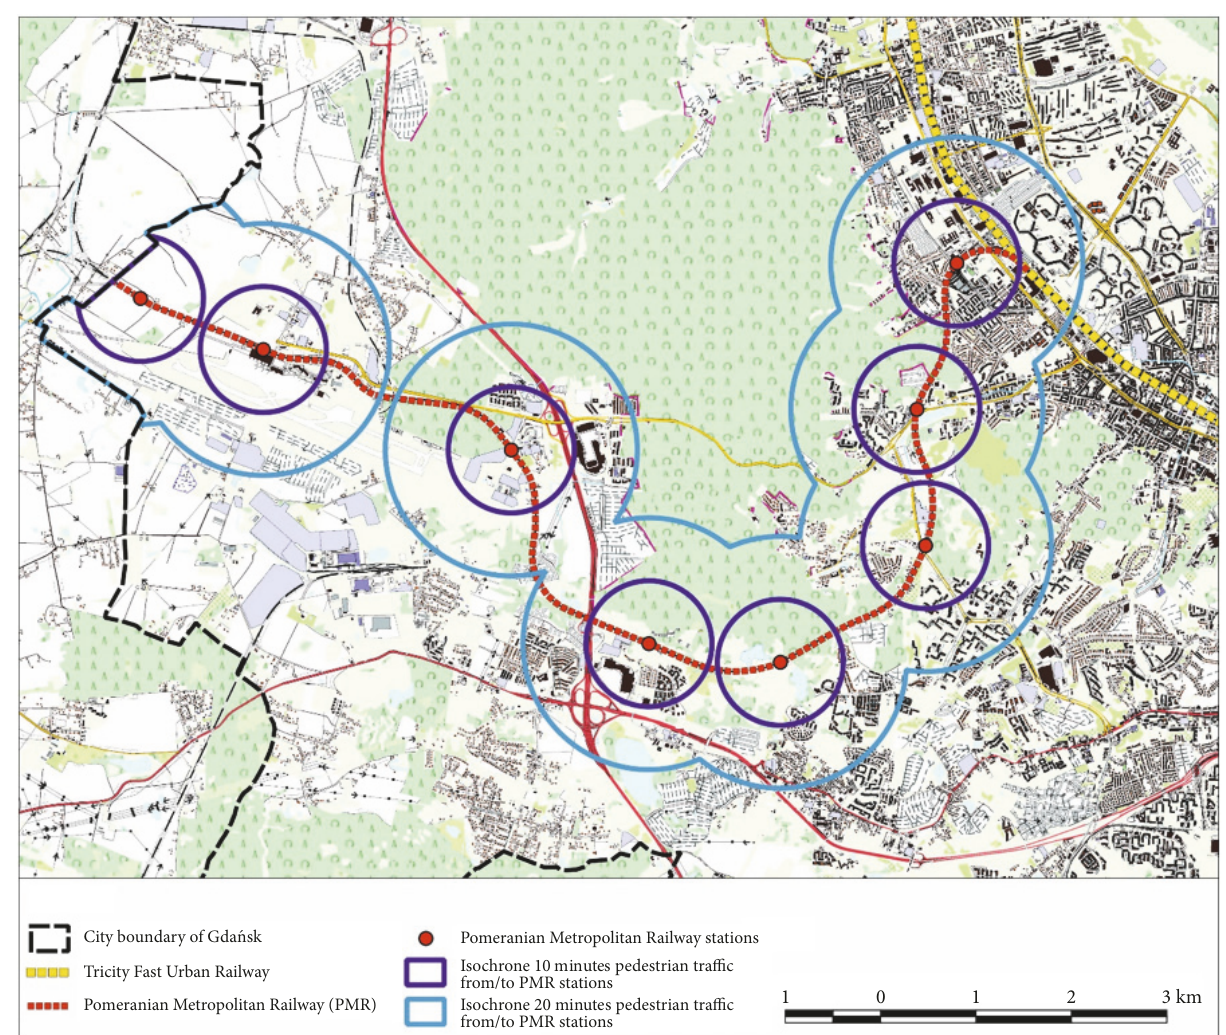
Figure 3: Zones of 10-minute and 20-minute walking accessibility to the PMR line in the context of the contemporary land use forms.